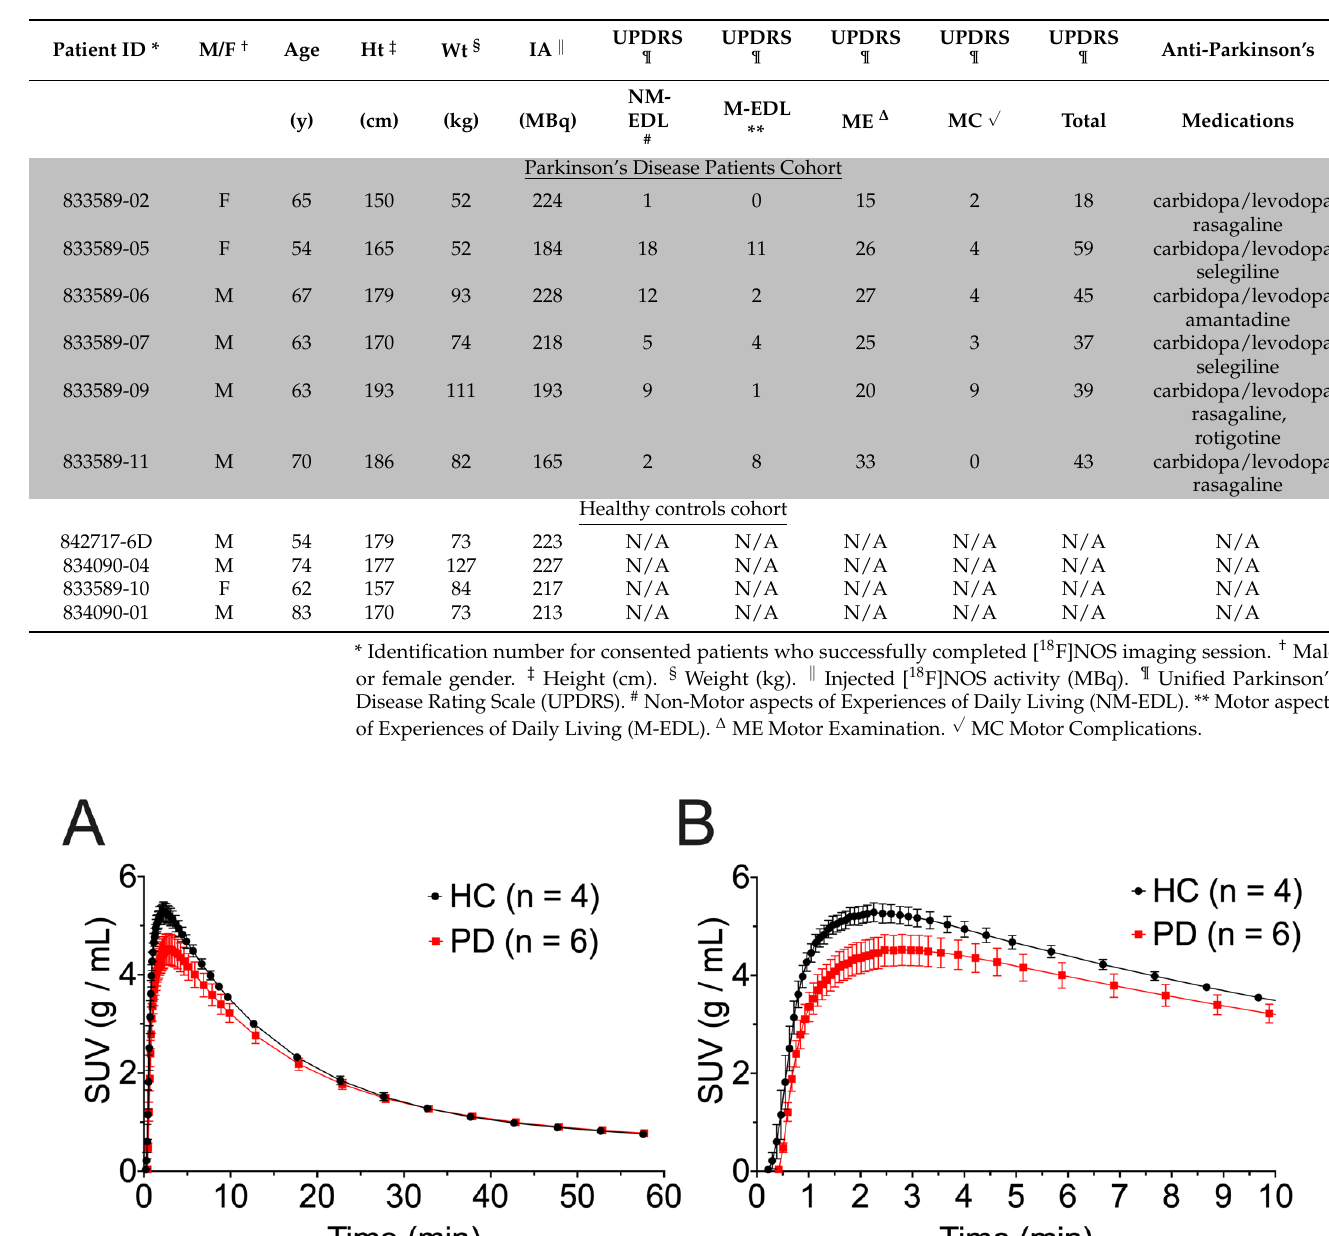
Table 1. Subjects’ characteristics.